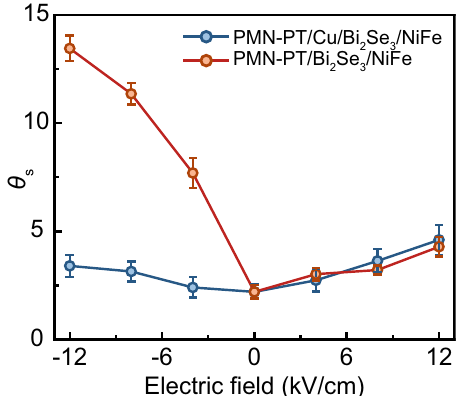
Fig. 4 Comparison of electric fi eld control spin Hall angle under the conditions with or without Cu dissipation layer between PMN-PT substrate and Bi 2 Se 3 layer. Error bars represent standard